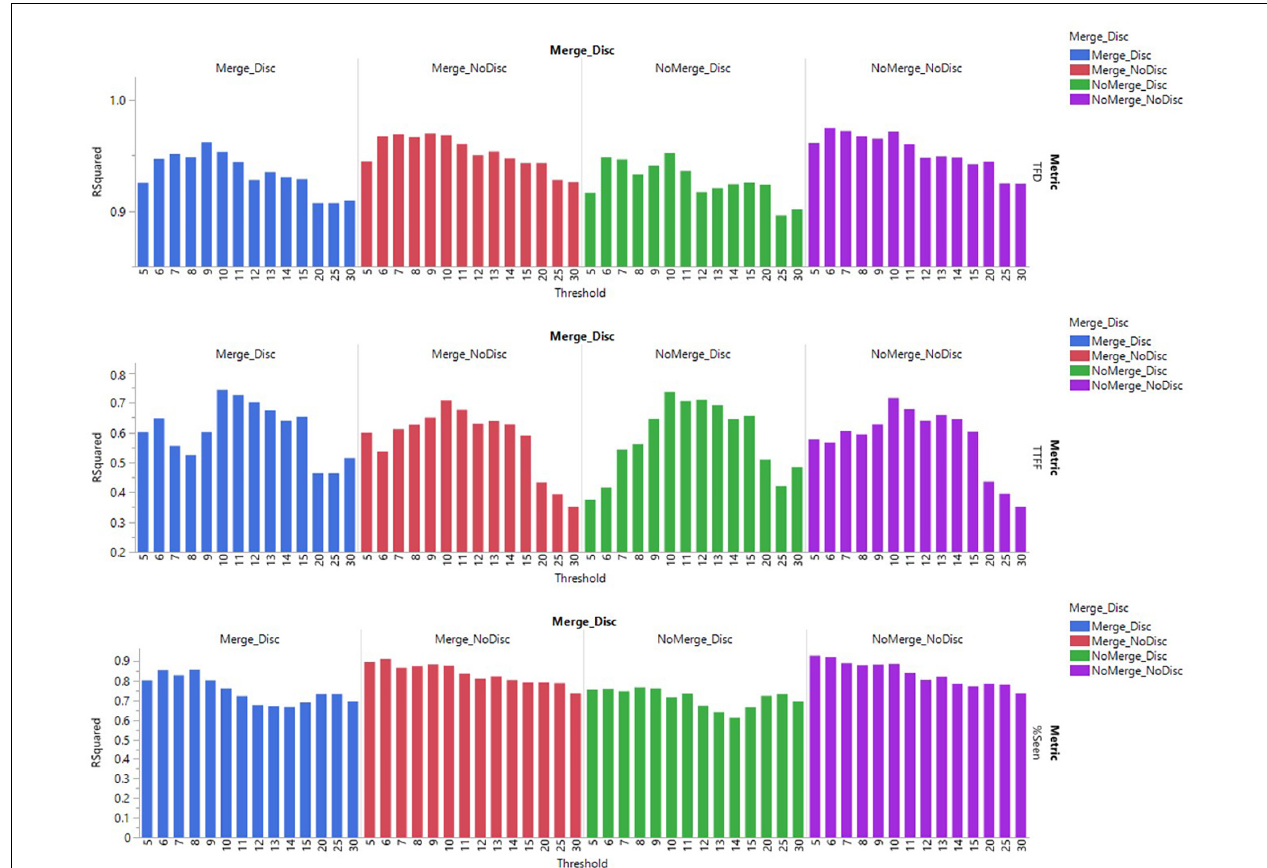
FIGURE 5 | Coefficient of determination for each of the Test filters and the benchmark of